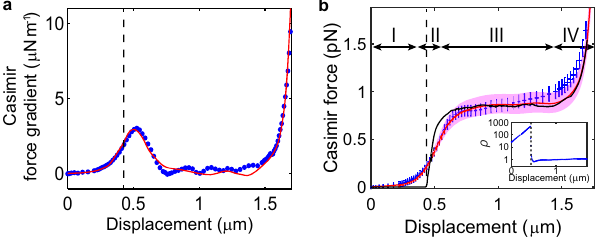
Fig. 4 Measured Casimir force and force gradient. a Measured Casimir force gradient (blue) as a function of displacement. The red line is calculated by SCUFF-EM based on the digitized pro fi les. The standard deviations over independent measurements are comparable to the dot sizes. b The measured force gradient is integrated over displacement to yield the force. Error bars are obtained from propagating the uncertainties in the measured force gradient. The red line is calculated by SCUFF-EM and the black line is generated by the PFA. The pink band shows the uncertainty of SCUFF-EM arising from the pixel size of micrographs (5 nm). The inset plots the ratio ρ of the measured force to the force calculated with the PFA. The dashed line labels where the